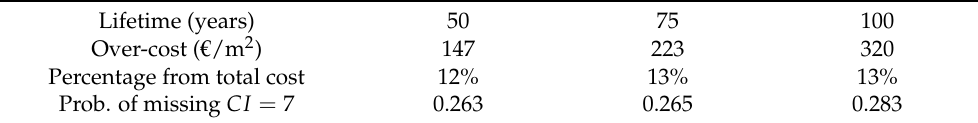
Table 6. Mean over costs and the probabilities of missing CI =